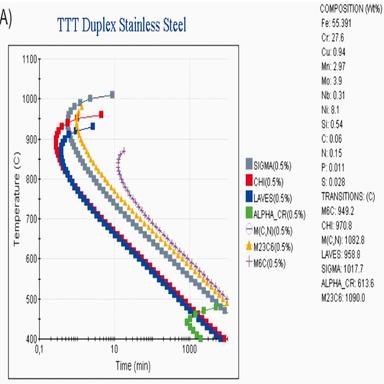
CALPHAD simulation of the soldering process in SDSS-Nb; a) TTT diagram for a temperature of 1090 ◦C; b) CCT diagram for a temperature of 1090 ◦C.